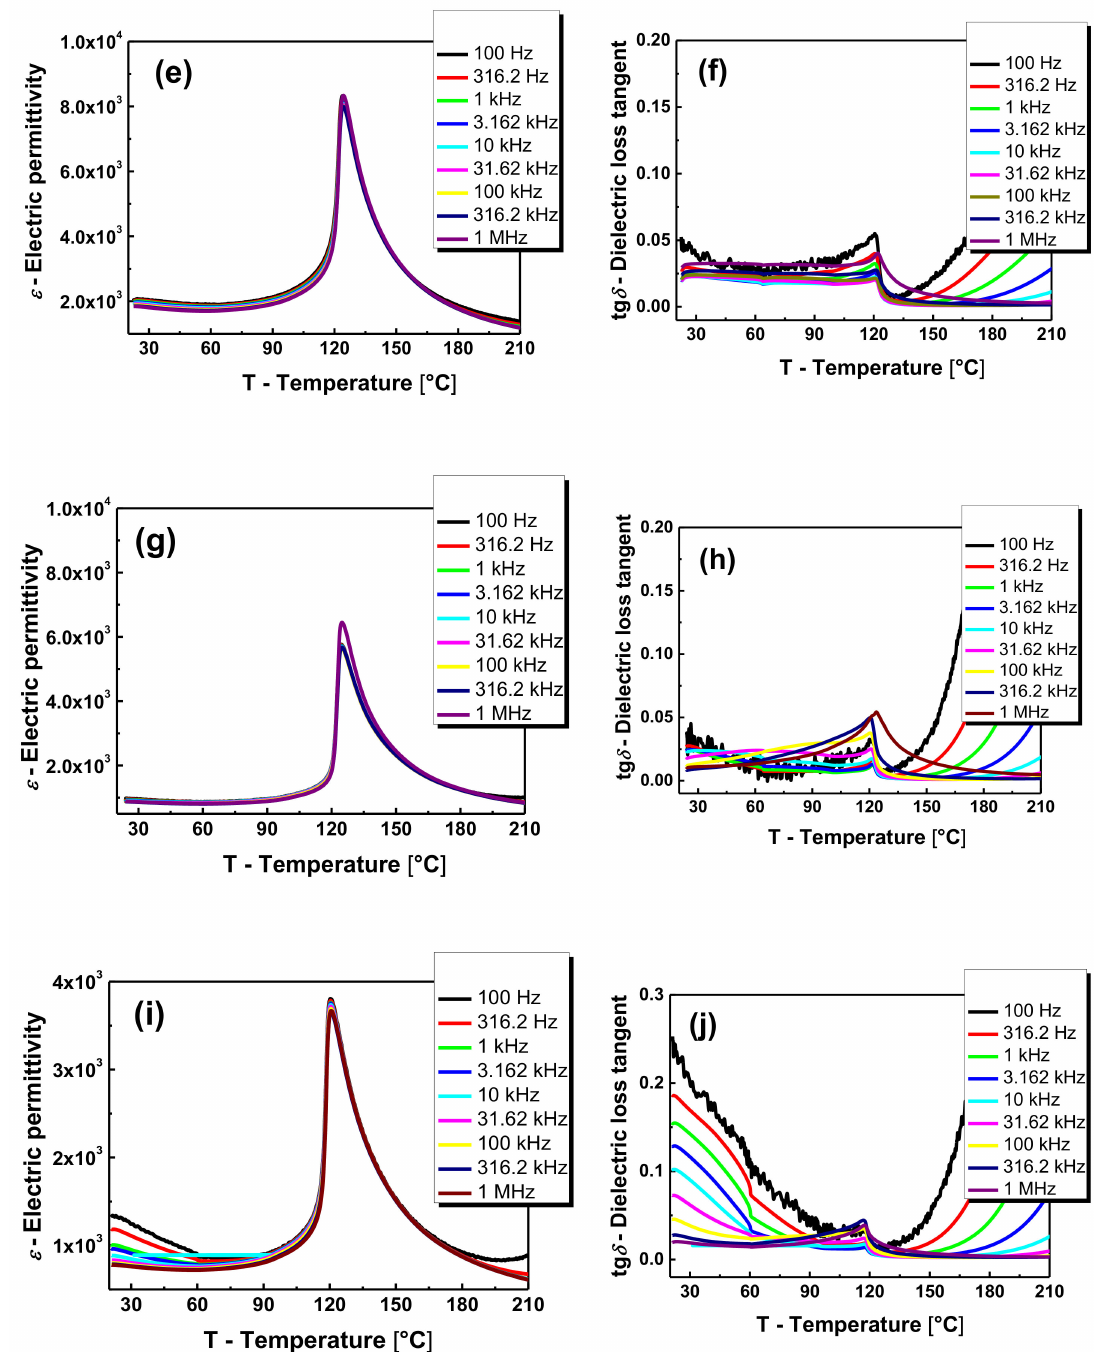
Figure 4. Temperature dependence of electric permittivity ε and dielectric loss factor tg δ measured at various frequencies of the measuring field for ( a , b ) BT, ( c , d ) BLTF1, ( e , f ) BLTF2, ( g , h ) BLTF3, ( i , j ) BLTF4